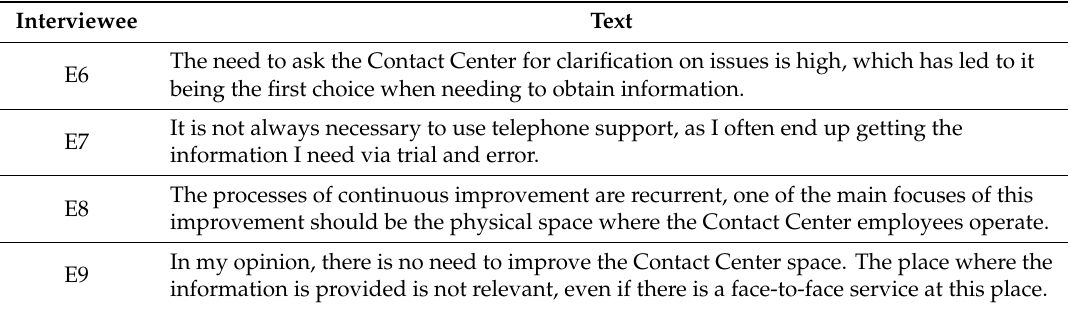
Table 2. Content Analysis—Impact of the Contact Center for the Air